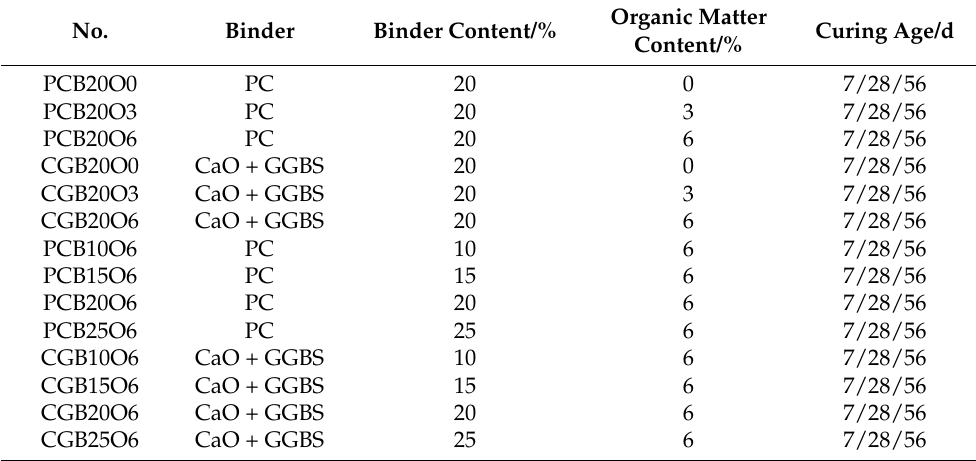
Table 3. Test scheme under different